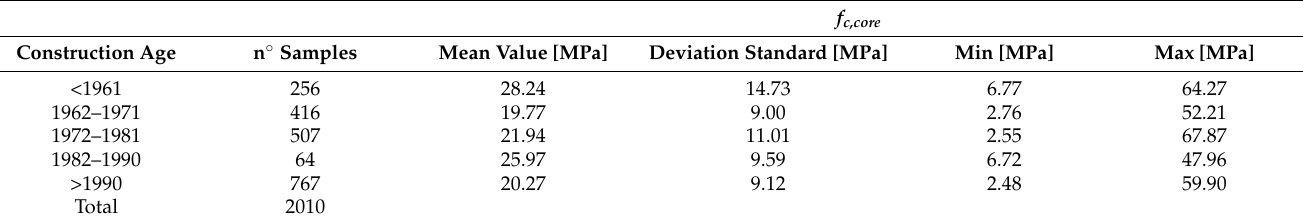
Table 1. DB_1: composition and main statistical